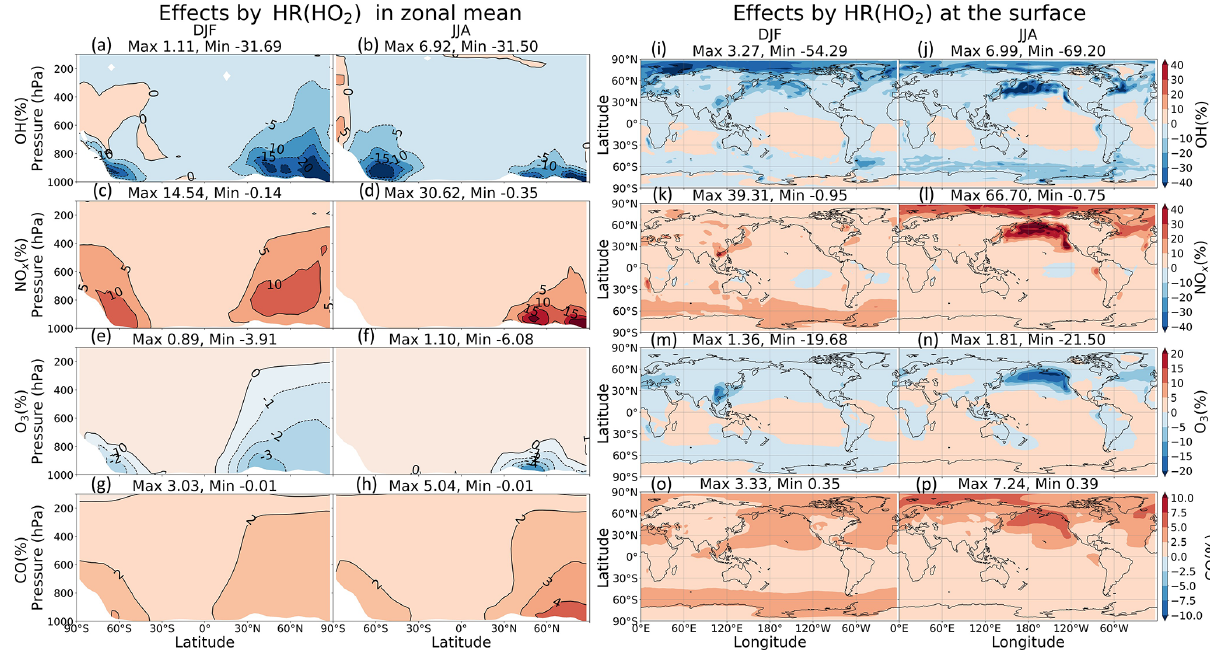
Figure 11. Effects of HR(HO 2 ) on both clouds and aerosols in zonal mean (a–h) and at the surface layer (i–p) . Note that the color scale for (a–h) is different from that for (i–p) .